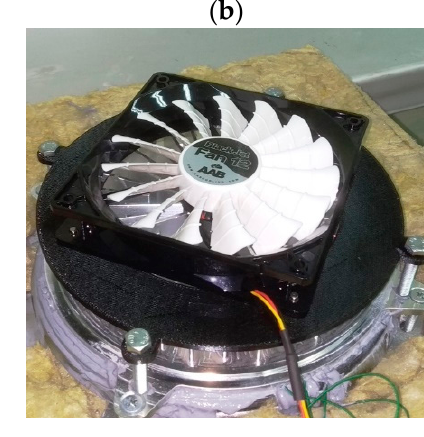
Figure 3. The test stand: SJA ( a ) and axial fan ( b